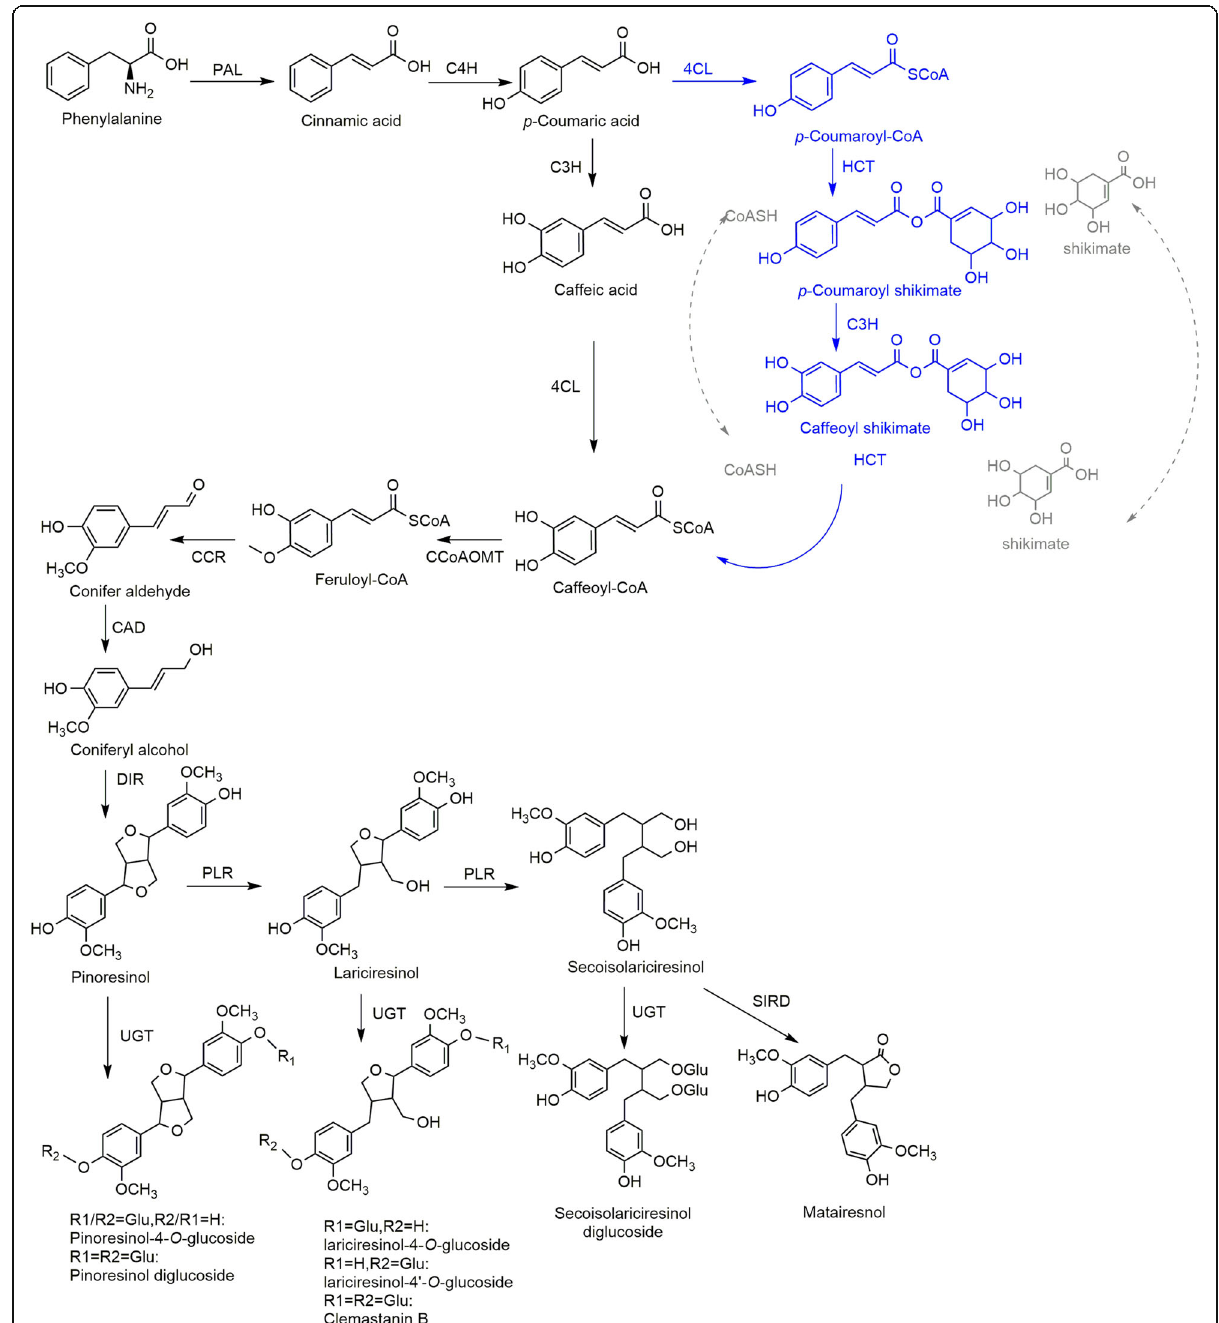
Fig. 2 Biosynthetic pathway of lignans in I. indigotica. Lignin and lignans come from caffeoyl-CoA, which could be produced from p-coumaric acid through caffeic acid or from p -coumaroyl-CoA through the CoASH-shikimate cycle. Active lignans and their corresponding derivatives in I. indigotica initiate from the dimerization of coniferyl alcohol. Blue and gray routes indicate different biosynthetic pathway leading to caffeoyl-CoA. The figure is adapted from Xiao et al. (2015) and Chen et al.